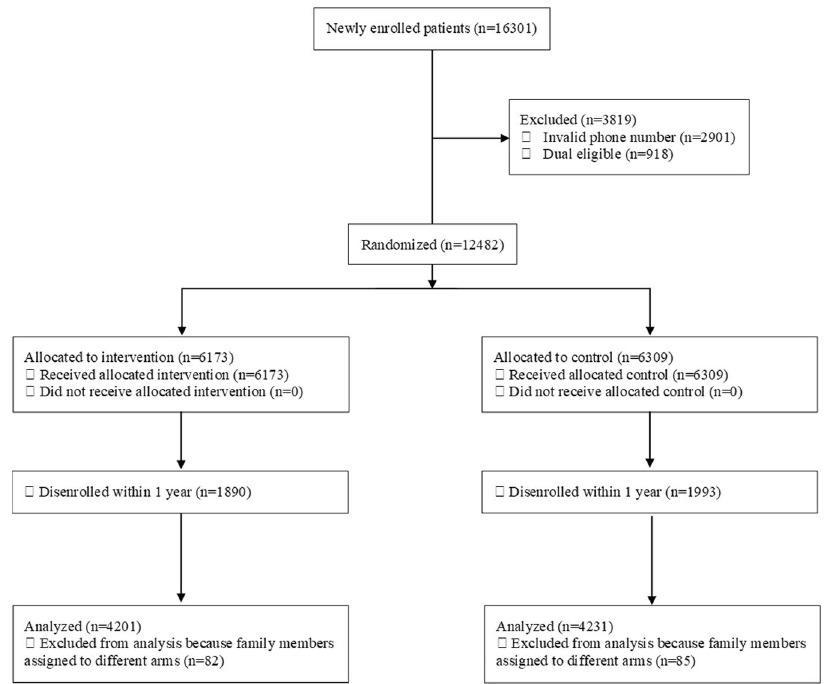
Fig. 1 Participant fl ow. The Consolidated Standards of Reporting Trials fl ow diagram. Table 1. Baseline participant